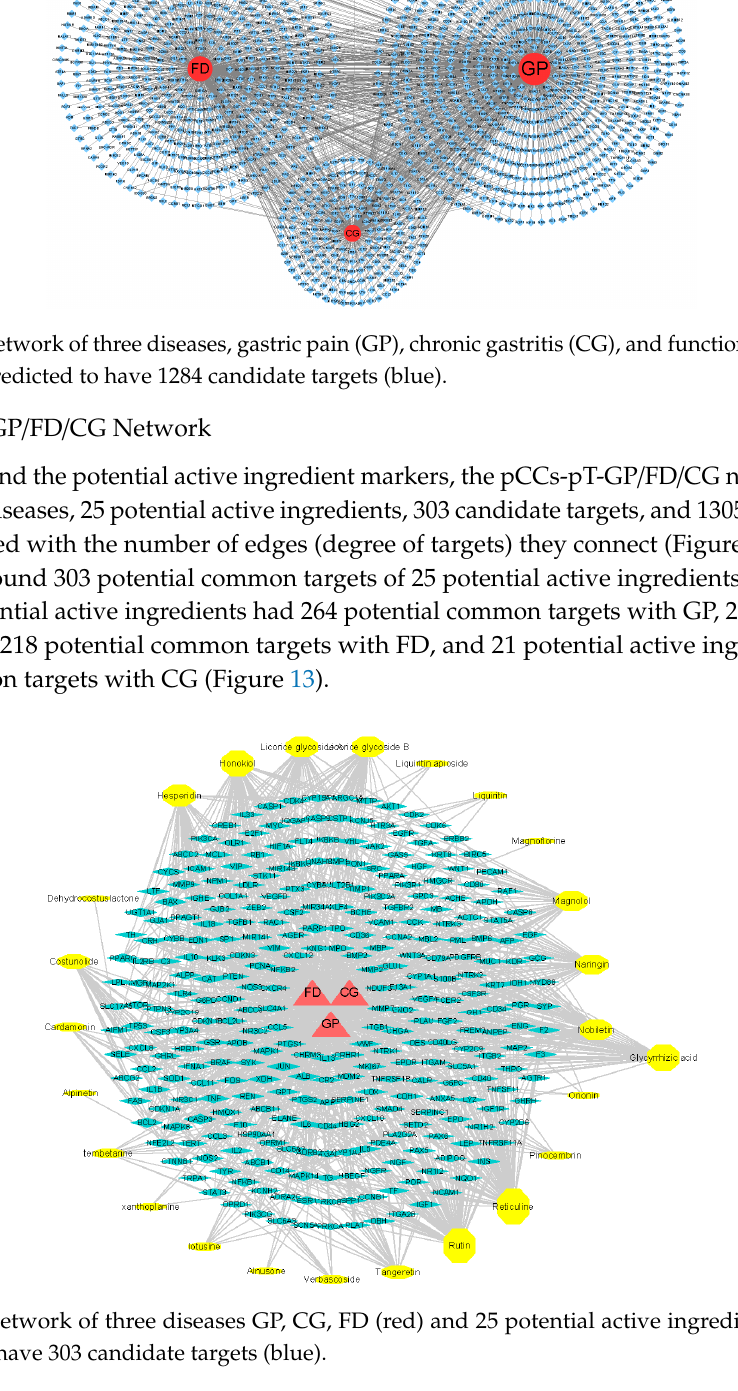
Figure 13. Distribution of 25 potential active ingredients in three diseases. 2.8. Establishment of the Method of Quantitative Determination by HPLC 2.8.1. Linearity Range, Limit of Detection (LOD), and Limit of Quantitation (LOQ) The mixed standard reserve solution containing four potential active ingredient markers was diluted into six appropriate concentrations and each concentration was tested three times. Calibration